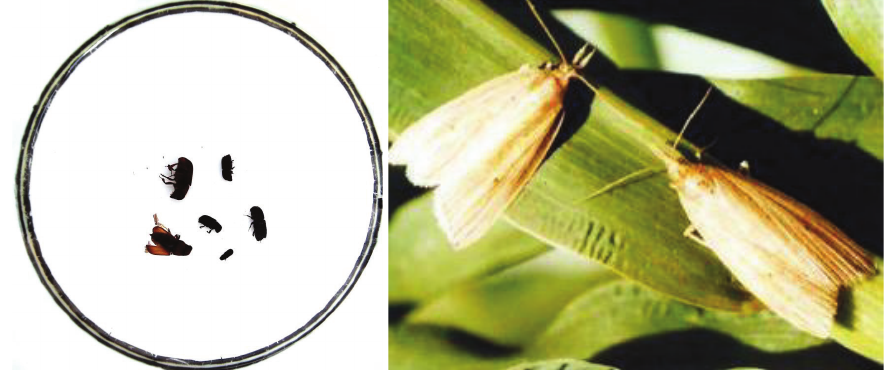
Figure 3. Two images of insect pests captured under a photographed lamp and photographed by cameras directly in the field successively.